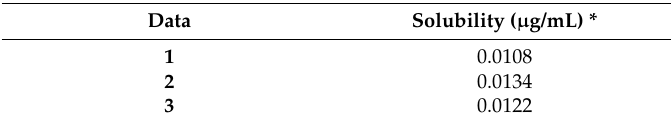
Table 4. Results of solubility of IVS320 from the triplicate